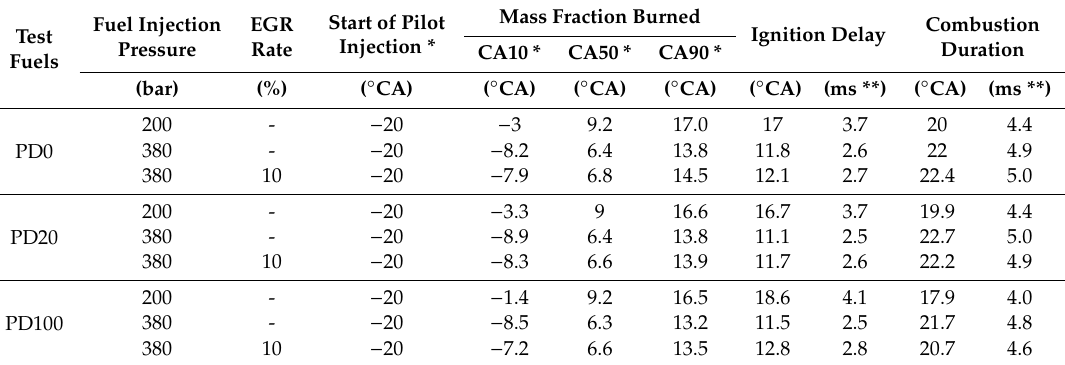
Figure 5. Mass Fraction Burned. ( a ) PD0, ( b ) PD20, ( c ) PD100, and ( d ) PD100 under 380 bar with EGR rate 10%. Table 4. Ignition delay and combustion duration under test conditions.